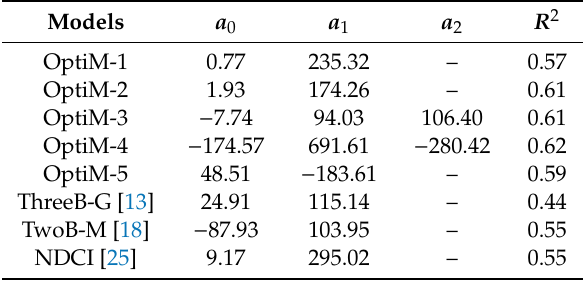
Table 3. Chl-a estimation models using regression fitness. The intercept and two slopes of the regression lines are denoted as a 0 , a 1 , and a 2 , respectively.